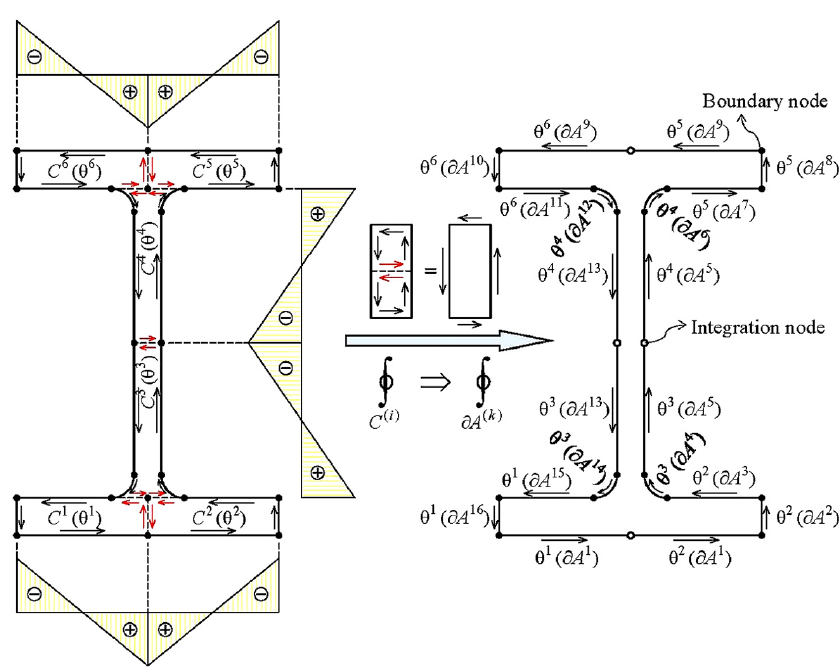
Fig. 6. Integration on the boundary ∂ A of the steel